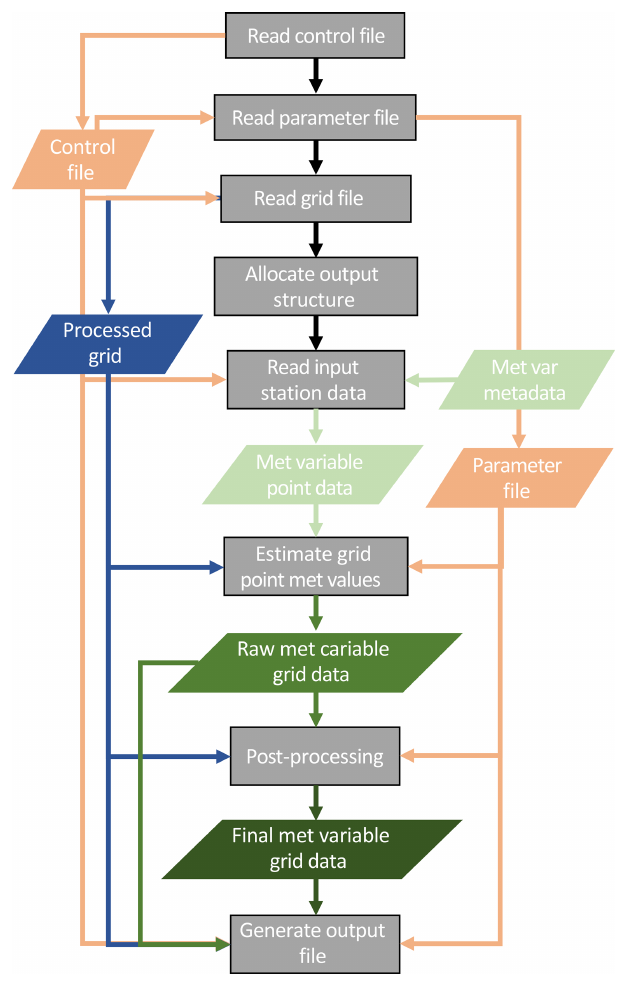
Figure 2. Flowchart describing the TIER processing algorithm in- cluding post-processing. Color shading is the same as that in Fig.